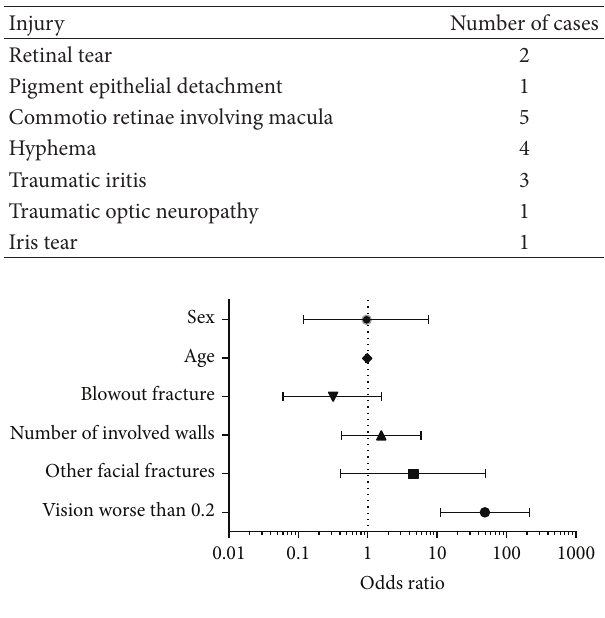
Table 2: Observed injuries.